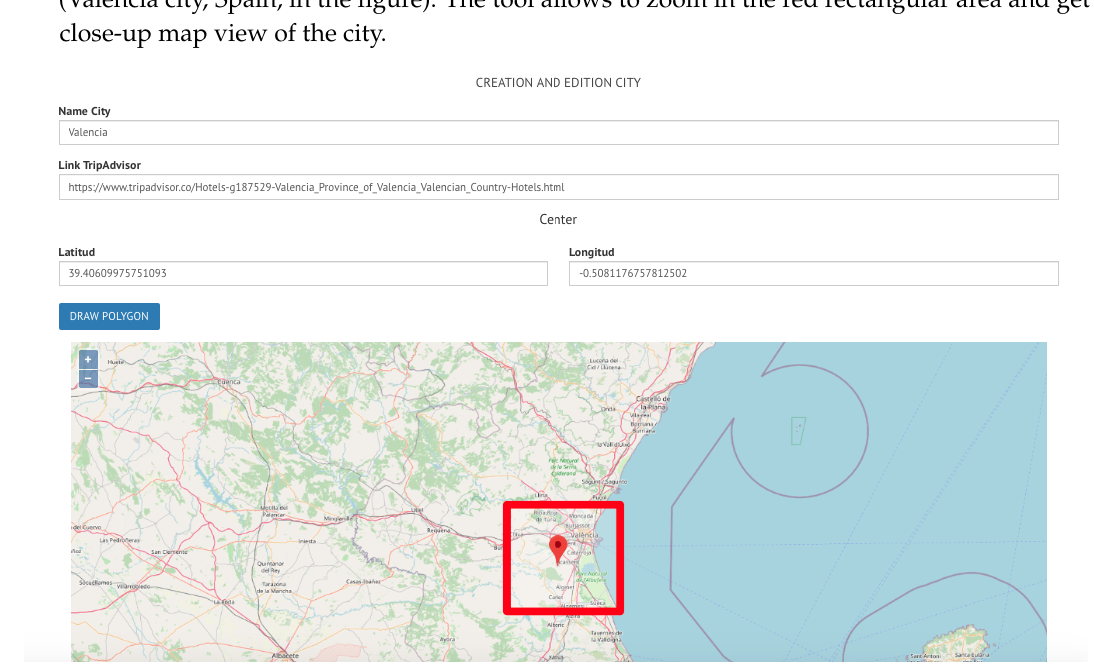
Figure 1. Destination definition in BITOUR